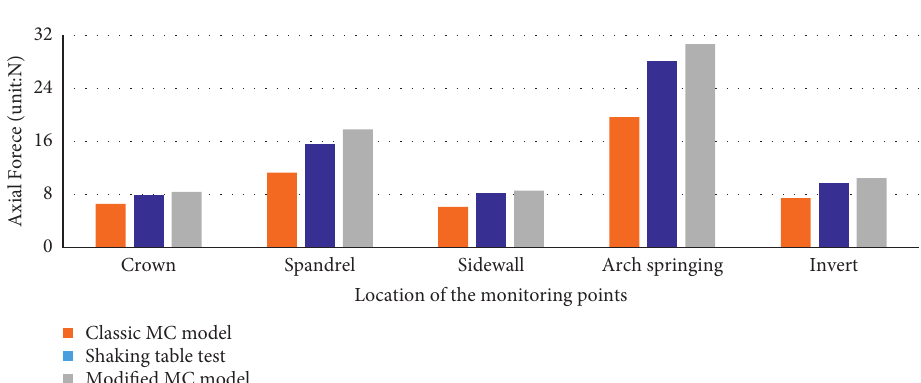
Figure 28: Histogram of the maximum axial forces at section 1 for the different yield criterion models.